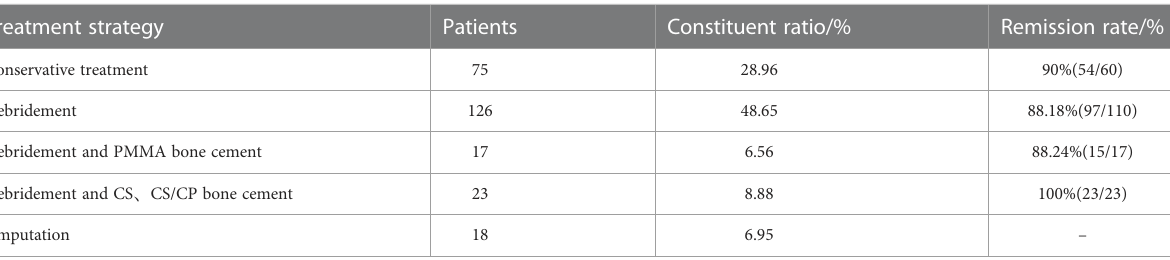
TABLE 6 Treatment strategy and remission